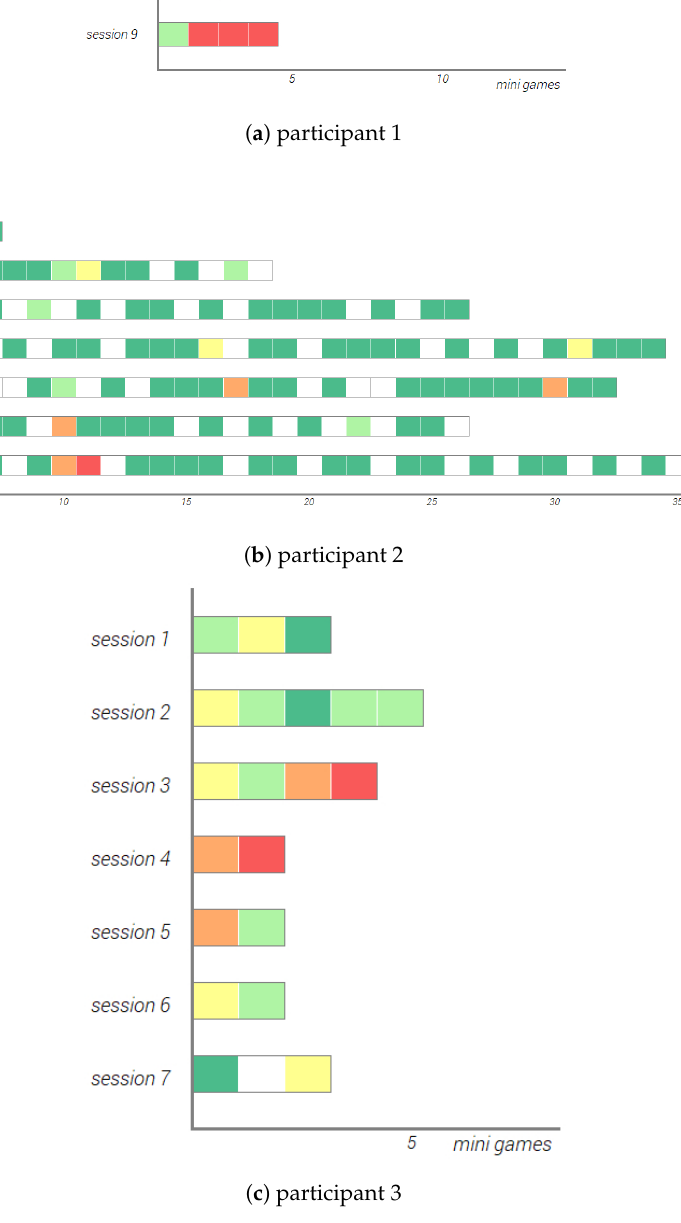
Figure 12. Evolution of the mood during a gaming